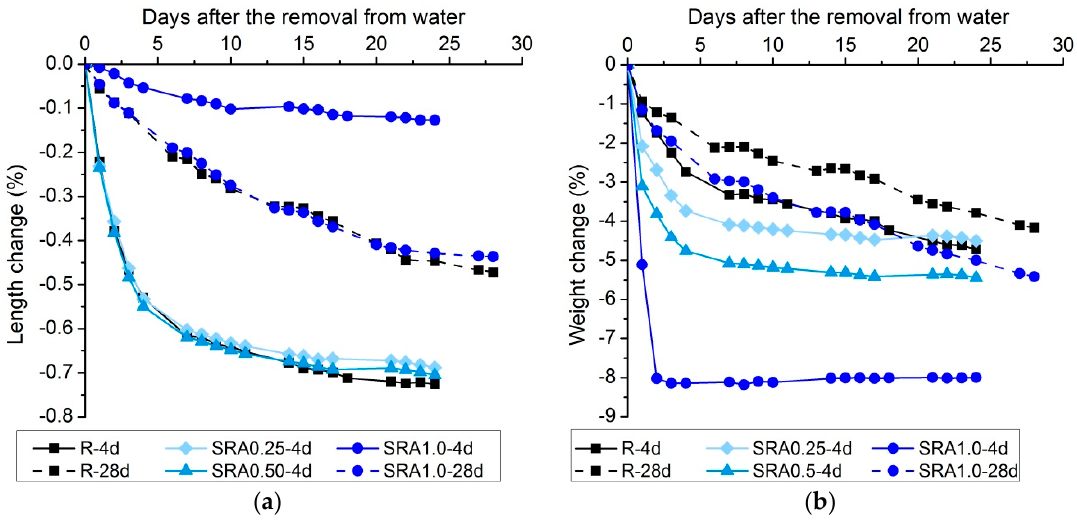
Figure 1. Effect of SRA on ( a ) drying shrinkage development and ( b ) weight loss development during drying of AAS mortars.